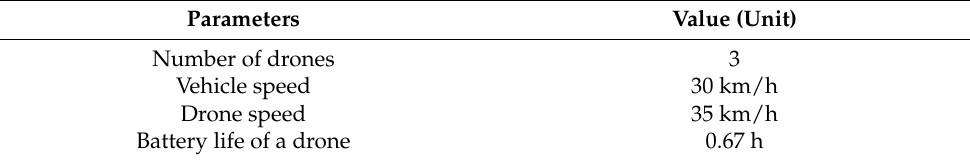
Table 3. Experimental parameter design.